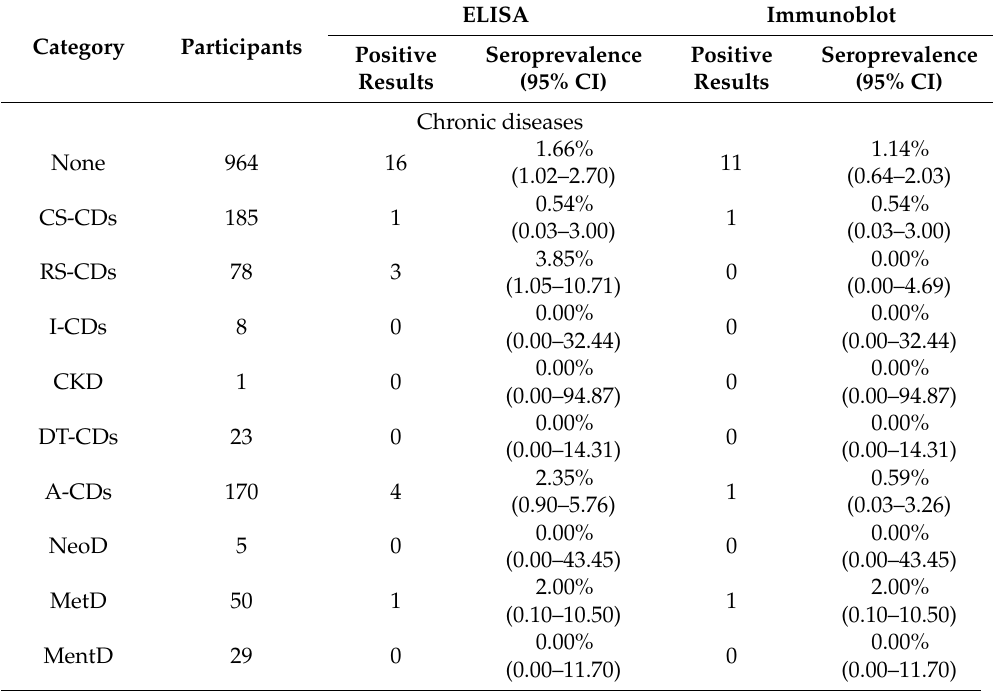
Table 2. Anti-SARS-CoV-2 seroprevalence related to health status and severity of last flu-like